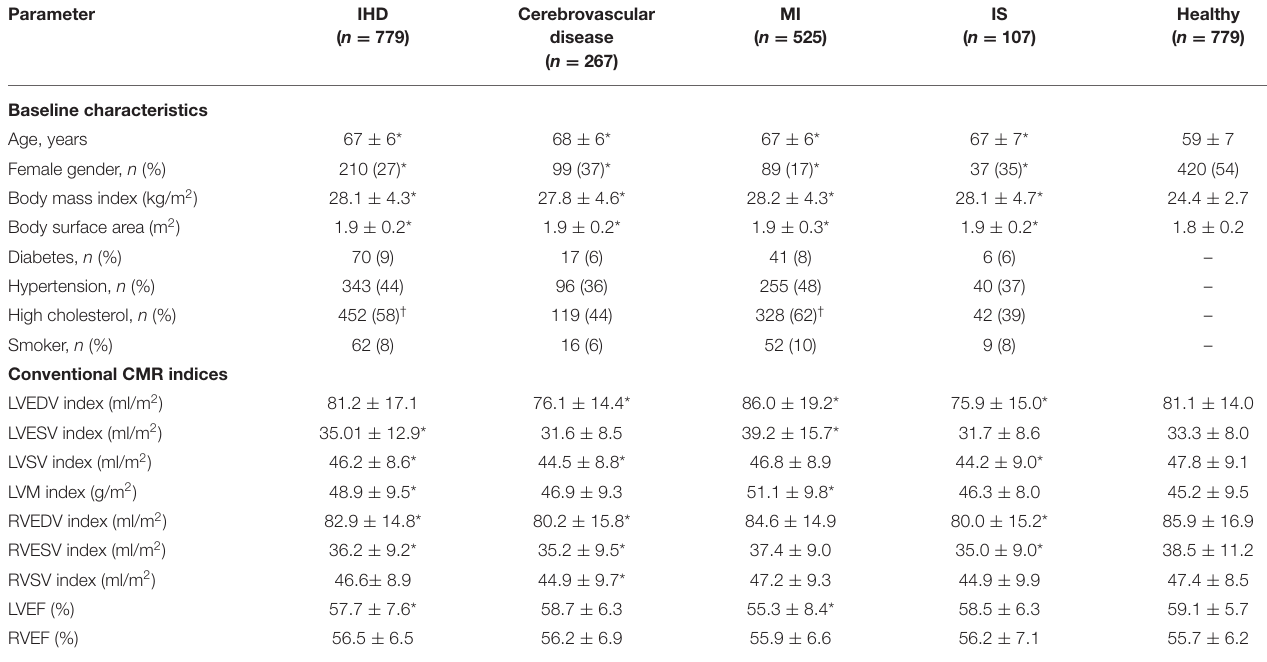
TABLE 1 | Baseline characteristics and conventional CMR measurements for each disease group and the healthy controls.